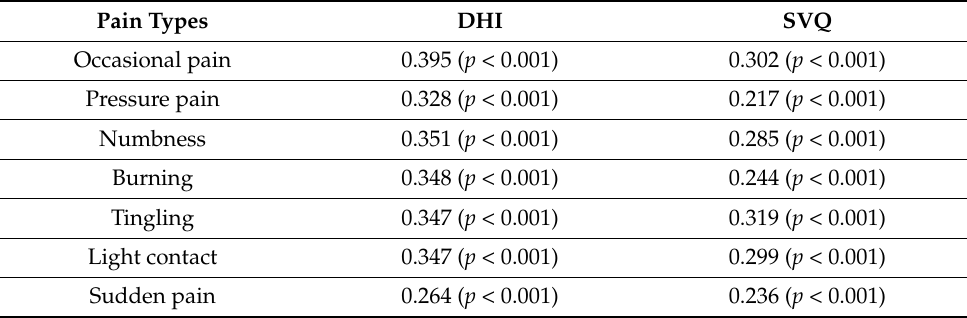
Table 5. Values of Spearman’s rank correlation ρ s between either Dizziness Handicap Inventory (DHI) or the Situational Vertigo Questionnaire (SVQ) scores and the scores of pain types as defined in the